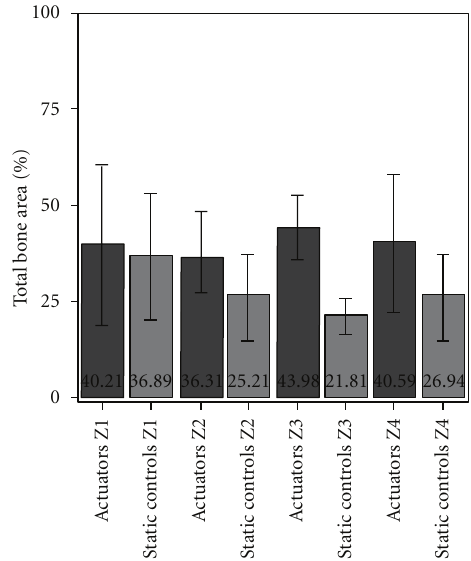
Figure 6: Total bone area measured around actuators and static controls, organized by areas Z1 to Z4. Bars represent means and error bars standard